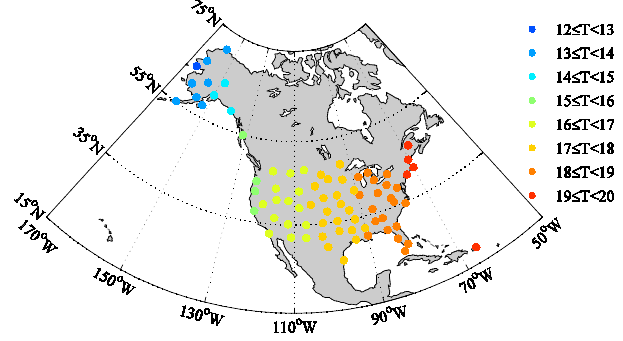
Figure 1. Local solar time of the radiosonde observation time (LST, in 00:00UTC) at the 79 stations over North America.